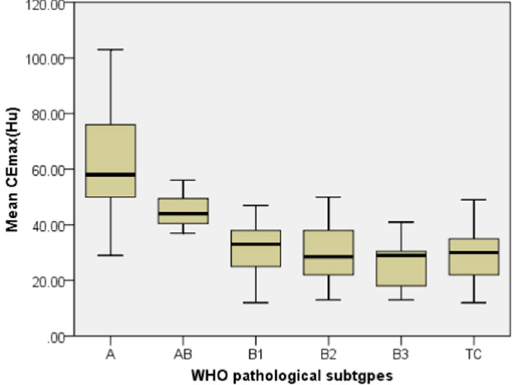
Figure 1. The relationship between mean CEmax(HU) and the WHO pathological subtypes of TETs. The mean CEmax values of type A or AB were significantly higher than for the other types (all P < 0.05), but there was no significant difference among Type B1, B2, B3, and TC (all P > 0.05).